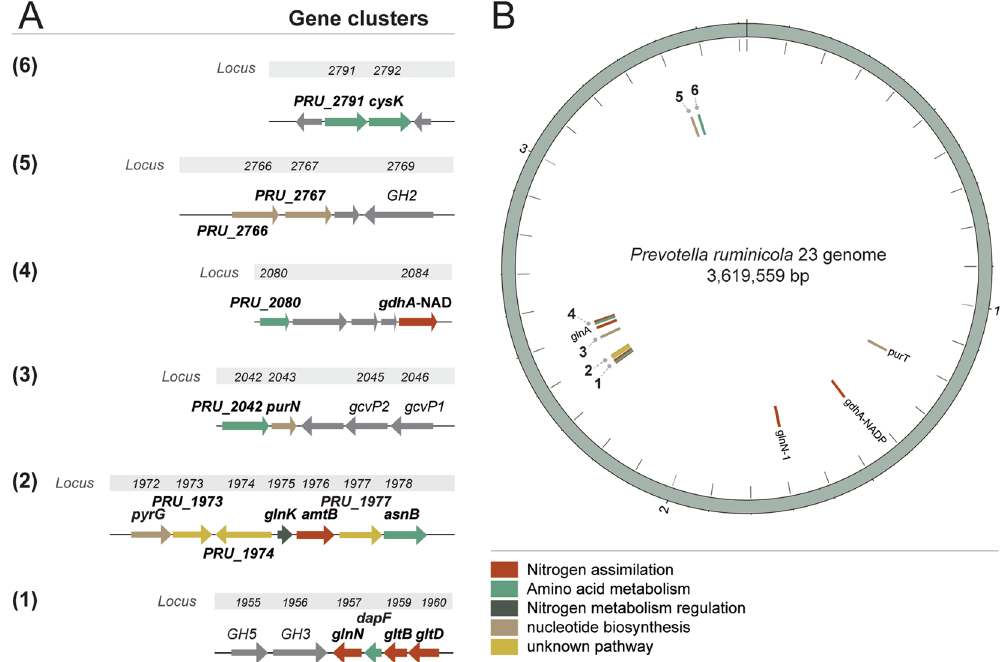
Figure 3. Gene clusters (1 to 6) for nitrogen uptake and assimilation in the genome of Prevotella ruminicola 23 ( A ), and genome map with corresponding numbered locations and gene coordinates ( B ). Color code represents functional categories for genes relevant to nitrogen metabolism in Prevotella ruminicola